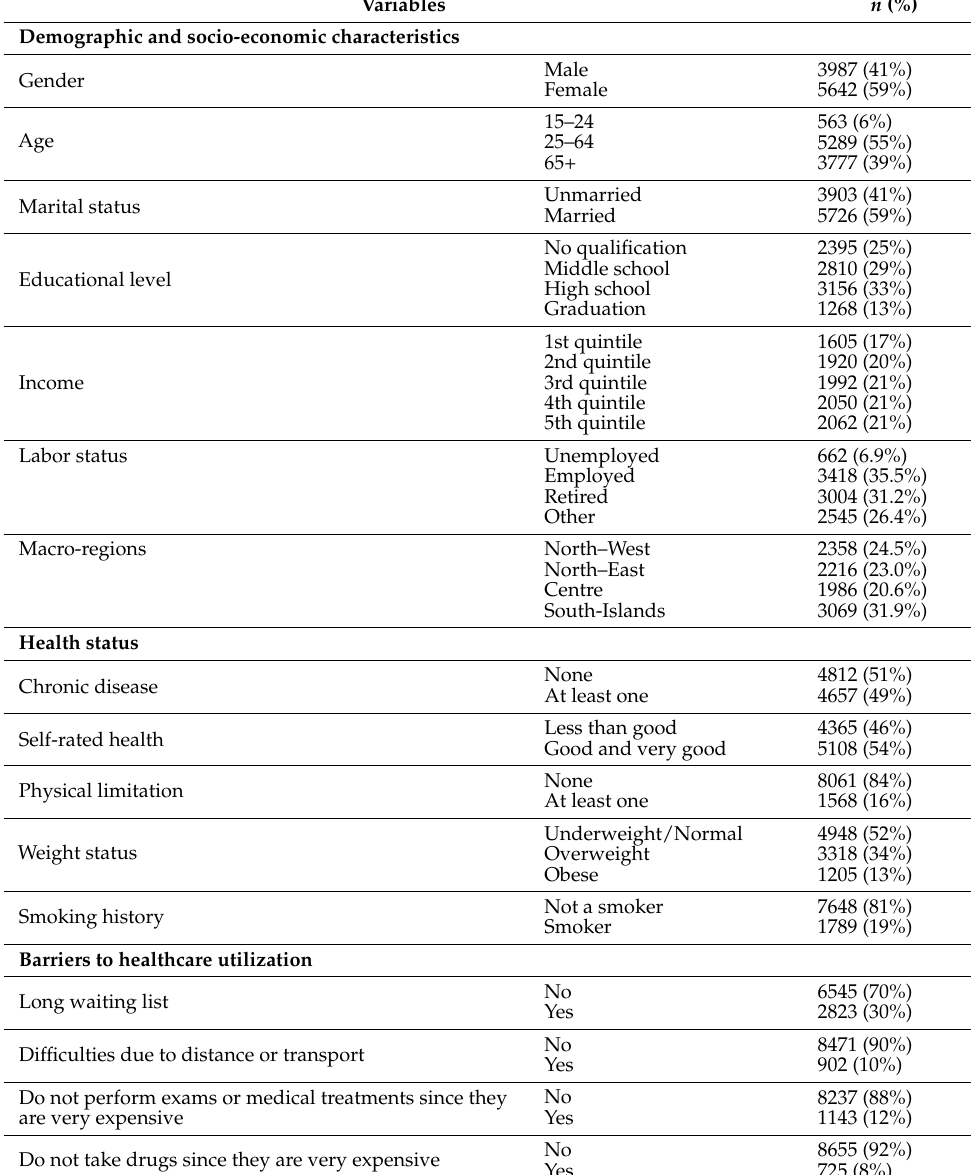
Table 1. Demographic, socio-economic characteristics, health status, and barriers to healthcare access of 9629 Italian individuals, aged 15 and